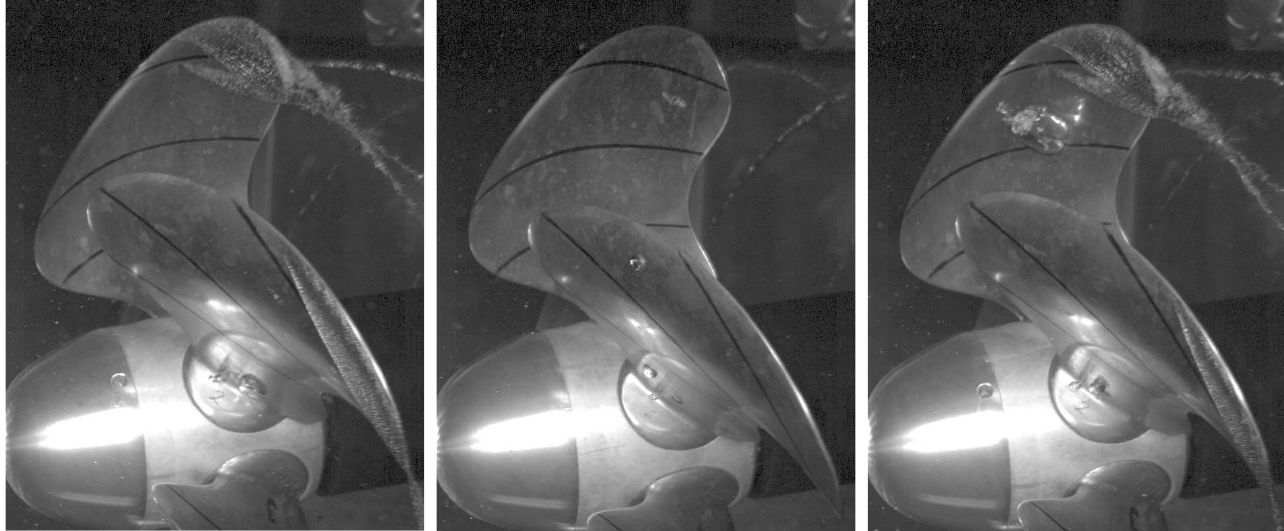
Figure 20. Typical cavitation patterns recorded in the experiments, J = 0.85, σ = 2.0. Left frame : typical cavitation pattern; middle frame : strip like cavitation on upper blade with traveling bubble on the lower blade; right frame : typical cavitation pattern with collapsing